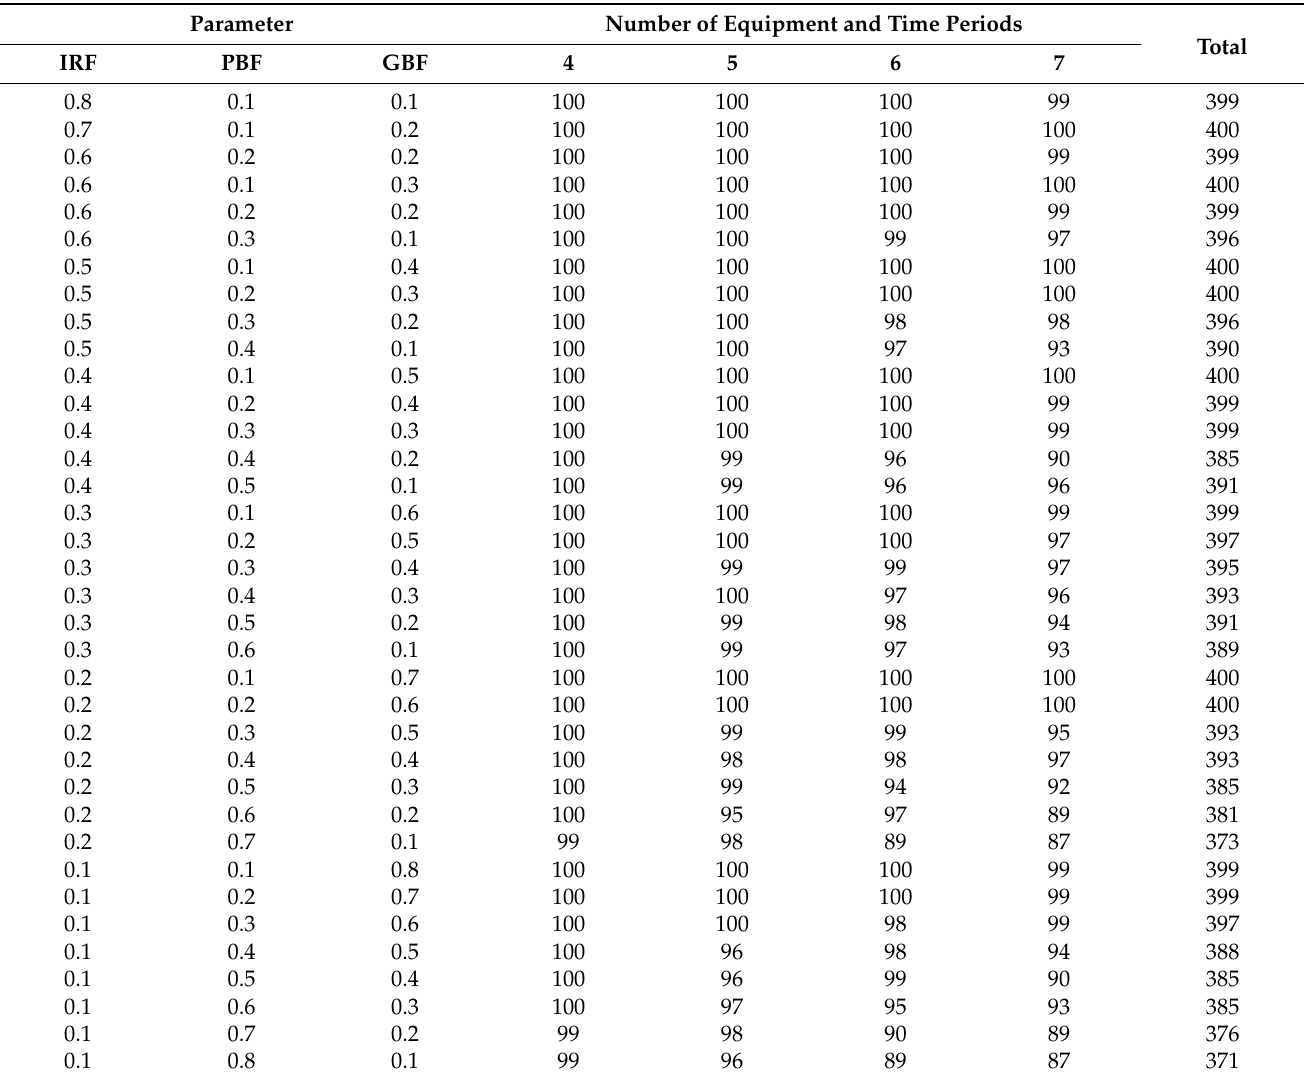
Table 2. Comparison of the number of successful tests of DPSO